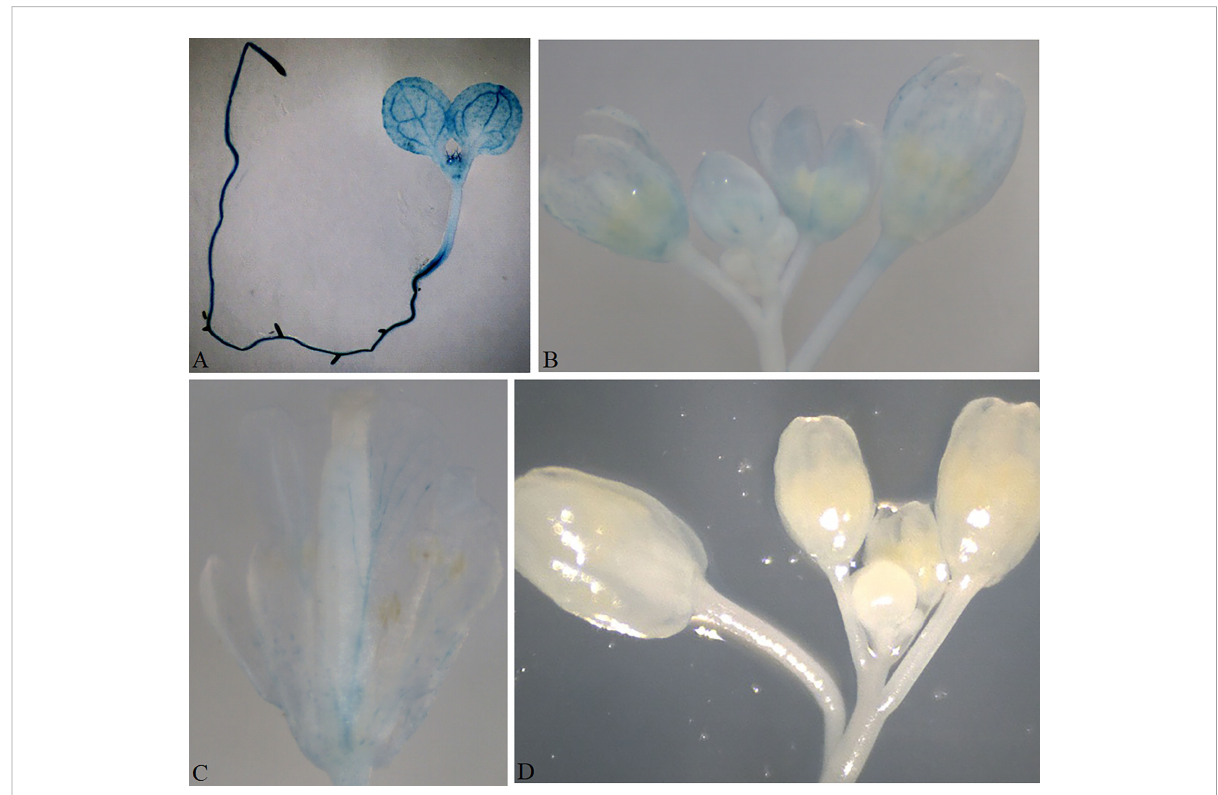
FIGURE 7 Validation of the promoter analysis vector in Arabidopsis . The GUS signal was observed in the cotyledon, shoot apical meristem, and the whole root of a 10-day-old transgenic seedling transformed with pRBTR1PGUS- AtGCS (A) . GUS expression in an in fl orescence (B) ; GUS expression in a single fl ower (C) . No GUS signal was observed in the Arabidopsis transformed with an empty pRBTR1PGUS vector as a negative control (D)